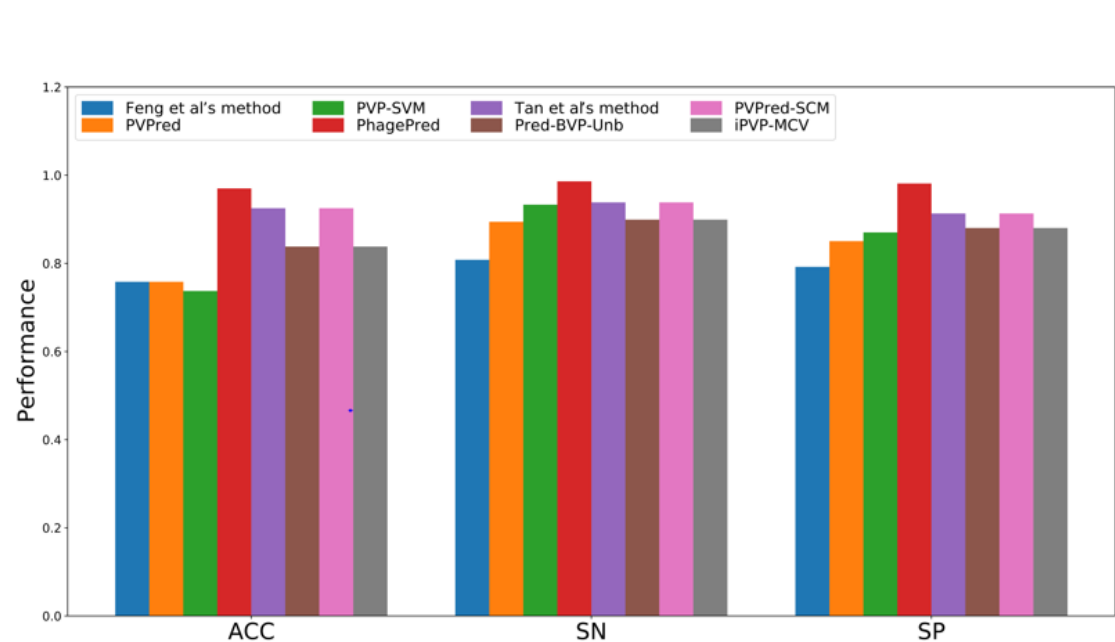
Figure 1: Performance evaluation on the Feng2013 dataset as deduced from 10-fold cross validation test